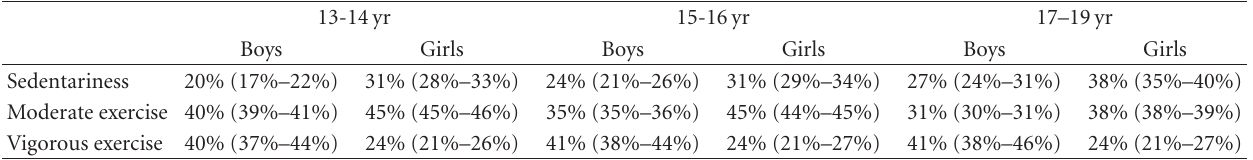
Table 2: Prevalence (95% confidence intervals between parentheses) of exercise participation in the di ff erent age groups as a function of sex.